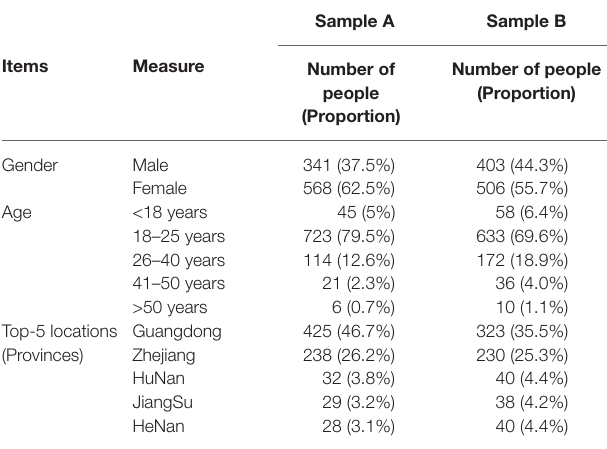
TABLE 1 | Description of the samples in study